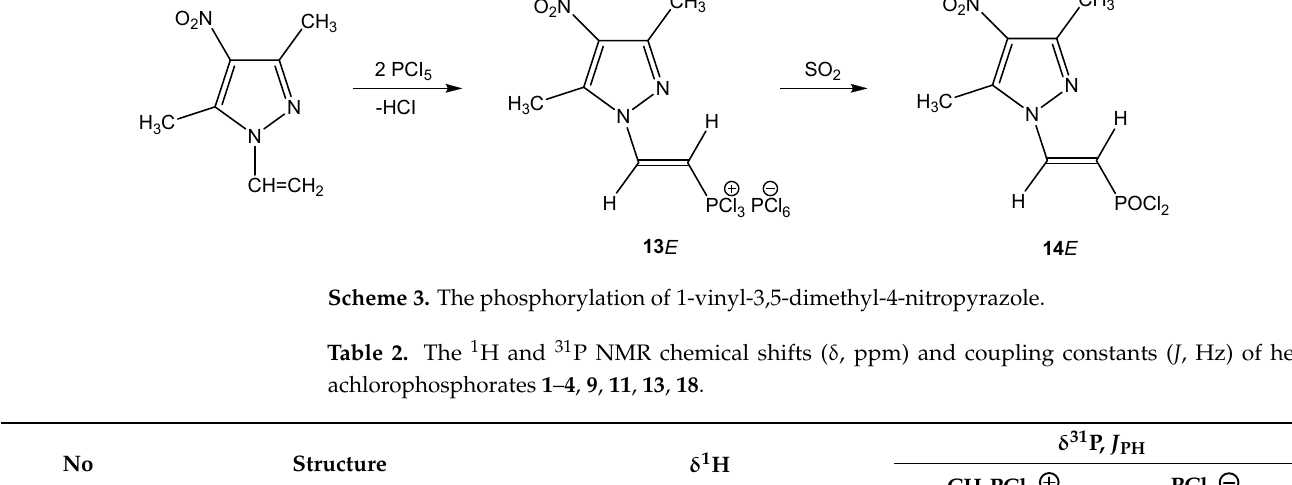
Table 2. The 1 H and 31 P NMR chemical shifts ( δ , ppm) and coupling constants ( J , Hz) of hexa- chlorophosphorates 1 – 4 , 9 , 11 , 13 , 18 .